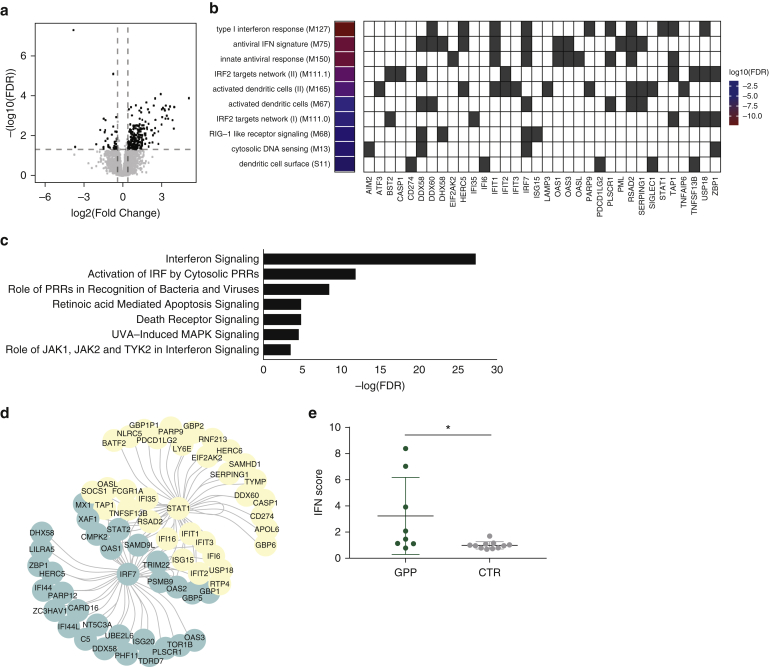
Transcription profiling of GPP neutrophils confirms the presence of a IFN-I signature. (a) Identification of genes that are differentially expressed in GPP. Horizontal and vertical lines represent significance and fold change thresholds, respectively. (b) Transcriptional modules enriched among the genes that are upregulated in GPP. The FDR for each module is reported, with the underlying upregulated genes shown as gray cells. (c) Enriched pathways detected among the genes that are upregulated in GPP. IFN-related pathways are highlighted in bold (d) Upstream regulator analysis showing that IRF7 and STAT1 drive the upregulation of numerous genes that are over-expressed in GPP. (e) Elevated IFN score in the neutrophils of patients with GPP, compared with controls. The data are presented as mean ± SD; *P < 0.05 (unpaired t test). FDR, false discovery rate; GPP, generalized pustular psoriasis; PRR, pattern recognition receptors; SD, standard deviation.